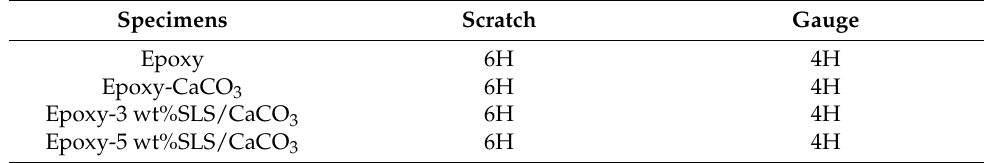
Table 5. The pencil hardness of all the